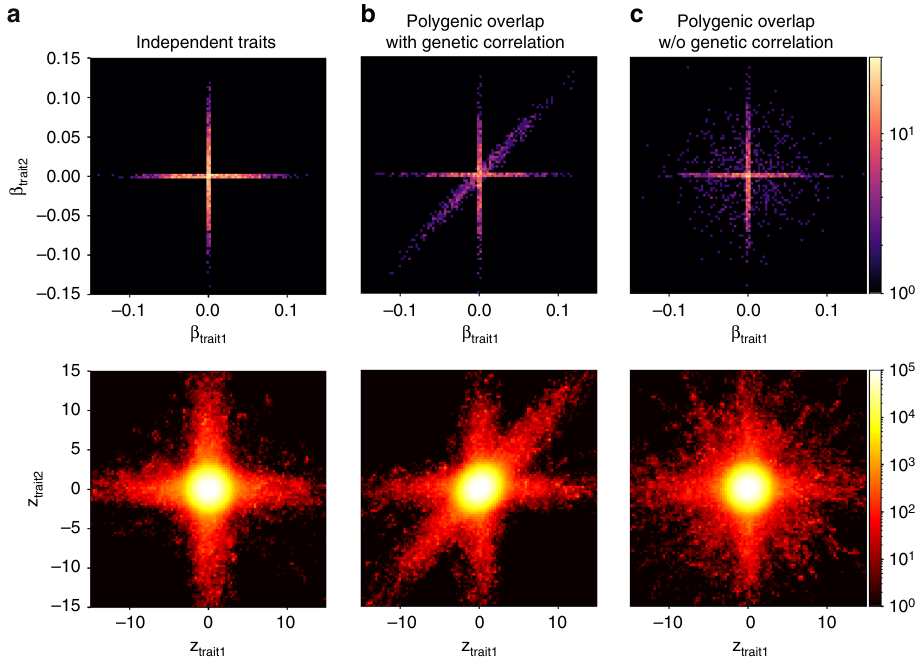
Fig. 1 Components of the bivariate mixture in three scenarios of polygenic overlap. All fi gures are generated from synthetic data, where causal variants were drawn from the MiXeR model, the total polygenicity in each trait is set to 0.01%, SNP heritability is set to 0.4, GWAS N = 100,000. First column shows two traits where causal variants do not overlap. Second column adds a component of causal variants affecting both traits in the same (concordant) direction. Third column shows a scenario of polygenic overlap without genetic correlation. Top row shows simulated bivariate density of additive effects of allele substitution ( β 1 j , β 2 j ), the bottom row shows bivariate density of GWAS signed test statistics ( z 1 j , z 2 j ) for GWAS SNPs (genotyped or imputed). Due to linkage disequilibrium, GWAS-signed test statistic has substantially larger volume of SNPs associated with the phenotype. The aim of the MiXeR model is to infer distribution of causal effects (top row), using GWAS data (bottom row) as an input. Figures are generated on a regular grid of 100 × 100 bins, color histogram indicates log 10 ( N ) where N is the number of SNPs projected into a